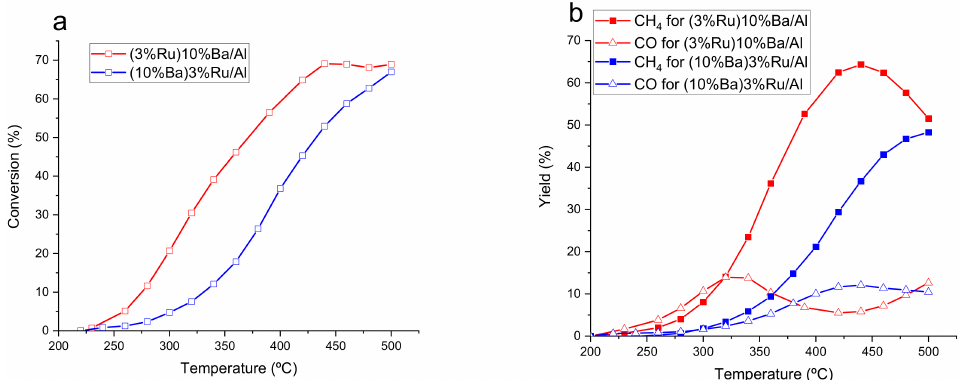
Figure 3. Comparison of the performance of the order of addition of the methanation metal and alkaline metal: ( a ) conversion, ( b ) CH 4 (filled symbols) and CO (empty symbols)